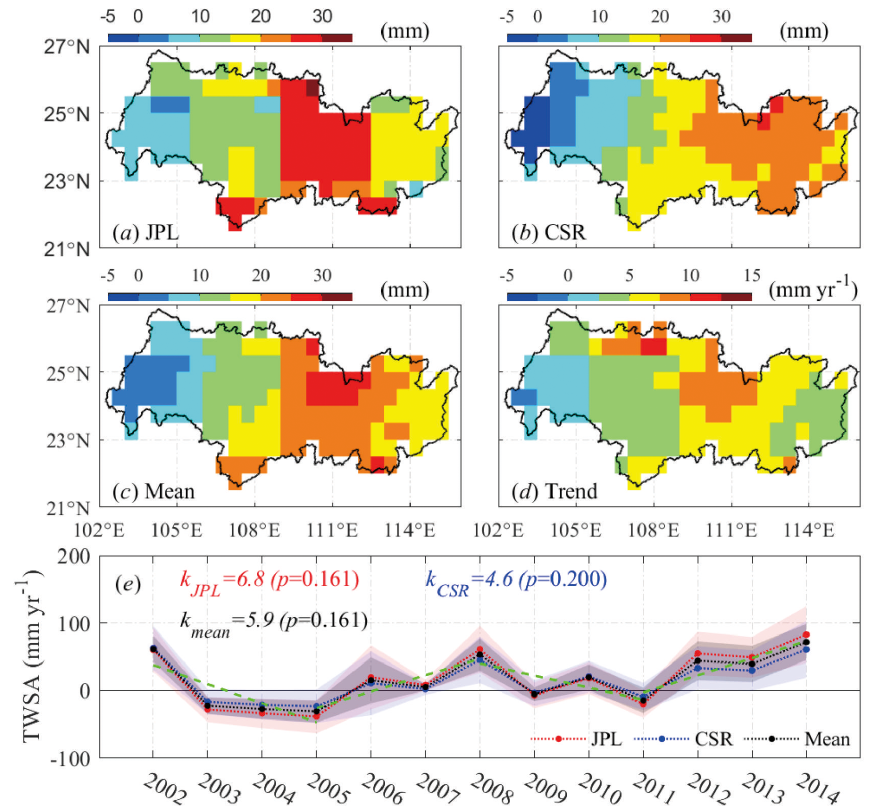
Figure 2. Spatial distribution of TWSA in the basin inferred by (a) GRACE JPL , (b) GRACE CSR , (c) the mean of GRACE JPL and GRACE CSR , (d) the linear trends of the mean annual TWSA, and (e) mean annual TWSA over the entire basin. Shaded areas in panel (e) show the standard error of each series. Dashed green lines indicate statistically insignificant trends ( R 2 = 0 . 68, 0.82, 0.58, and 0.83,